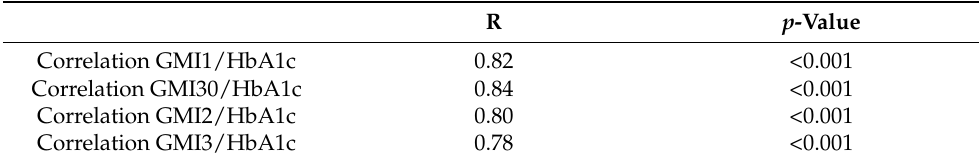
Table 3. Correlation between GMI of selected time spans and